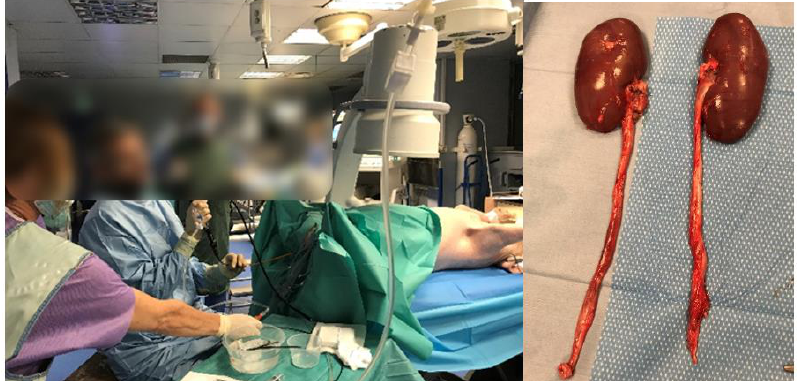
Figure 2. Female pigs (~40 kg). All procedures were performed under general anesthesia and the pigs were placed in the dorsal position. After the first procedure, pigs were kept alive and a second ureteroscopy was performed 18 days later to check for endoscopically tissue lesions. Animals were then sacrificed, and organs were removed for anatomopathological